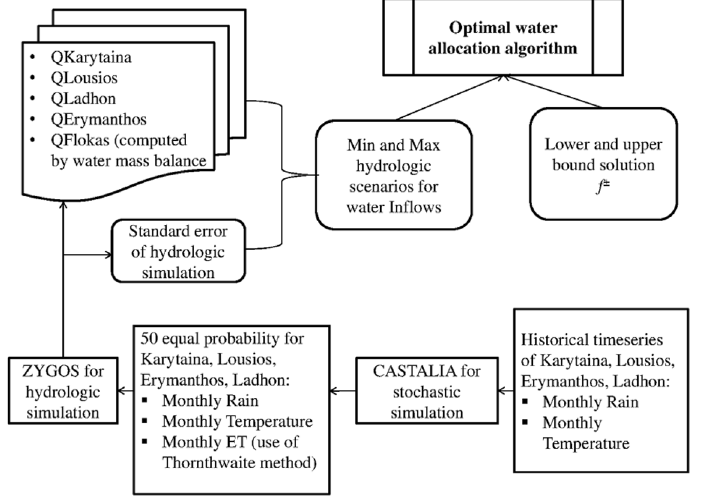
Figure 3. Methodological framework for optimal water allocation of Alfeios River